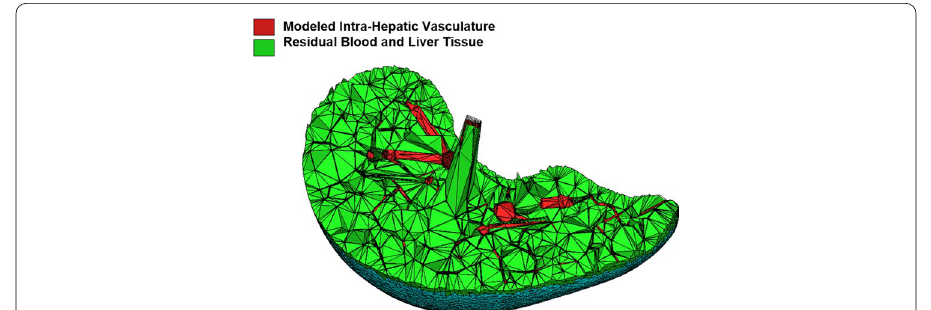
Fig. 3 Tetrahedral mesh‑type model of the AML. Red tetrahedrons represent the vascular model generated, and green tetrahedrons are a homogenous mixture of residual blood and liver